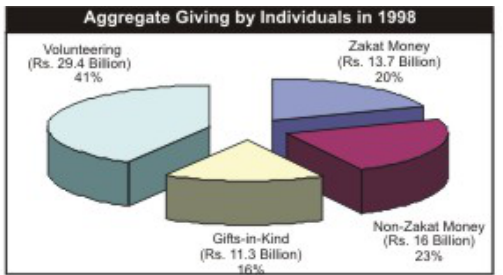
Figure 1.2: Source: Pakistan Center for Philanthropy